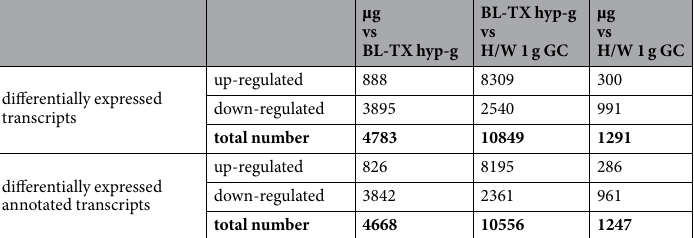
Table 4. Numbers of differentially expressed transcripts in comparisons of the experiment groups of TEXUS-49 suborbital ballistic rocket campaign. Differential expression is defined as t-test p-value < 0.05; fold change ≤ − 1.3 or ≥+ 1.3. The term “transcripts” refers to all 45034 transcripts of the array, whereas “annotated transcripts” refers to the 42947 transcripts that are annotated to a Transcripts were primarily upregulated in hypergravity and down-regulated in microgravity. Figure 4 summarizes the number of differentially expressed genes in the parabolic flight and suborbital ballistic rocket experiments. Whereas up- or down-regulation was almost equally distributed in differentially expressed transcripts after 20 s of altered gravity (Fig. 4a), longer periods of hypergravity resulted in primarily up-regulation of transcripts and longer periods of microgravity in down-regulation of transcripts (Fig. 4b). In the case of the ion channel inhibitor SKF-96365 enhancing the effect of microgravity, transcripts were primarily up-regulated, in the case of SKF-96365 reversed the effect of microgravity, transcripts were almost equally distributed between up- and down-regulation (Fig. 4c).